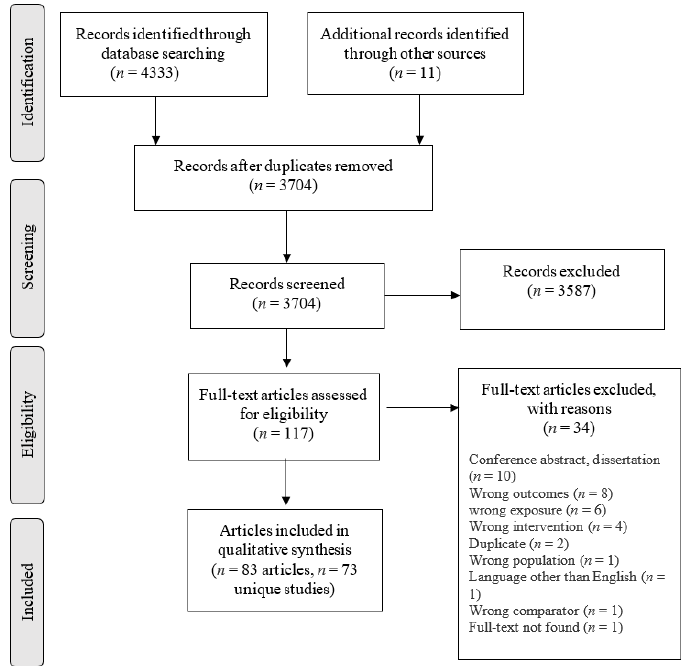
Figure 1. PRISMA flow diagram.